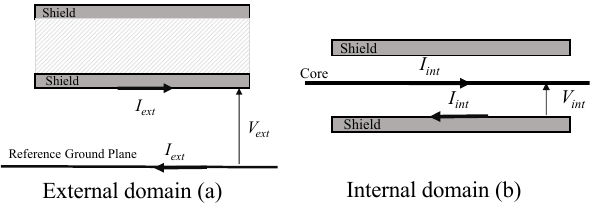
FIGURE 2. Coaxial cable: exterior (left) and interior (right) TL linear-sections of the external domain and internal domain